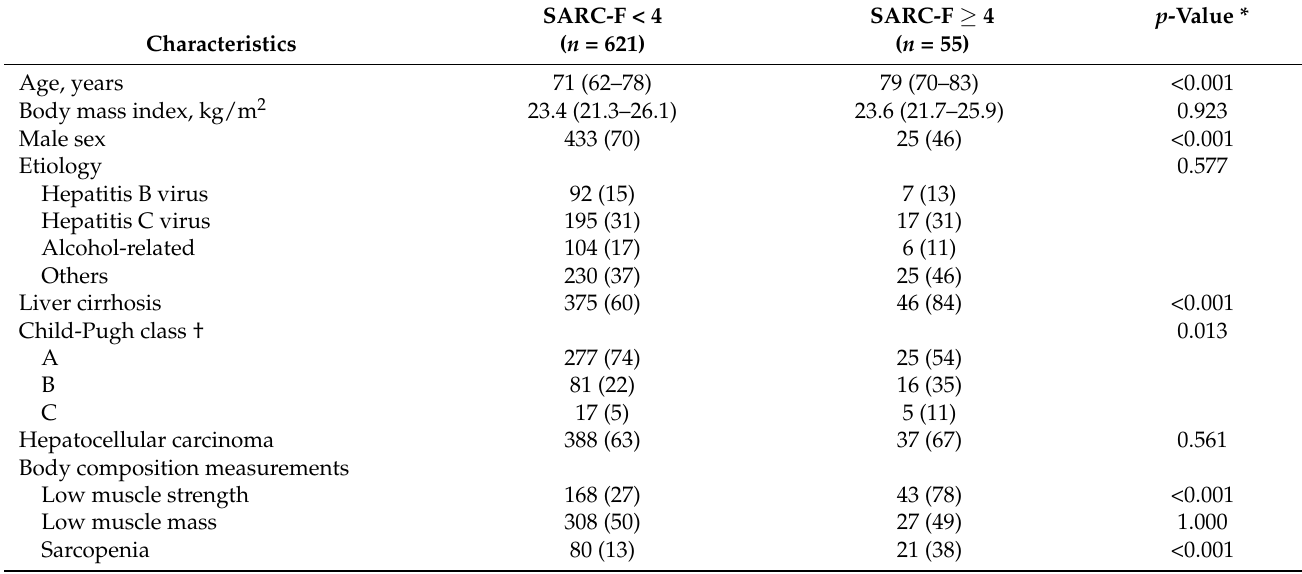
Table 3. Comparison of baseline characteristics of patients with a SARC-F < 4 and those with ≥ 4.